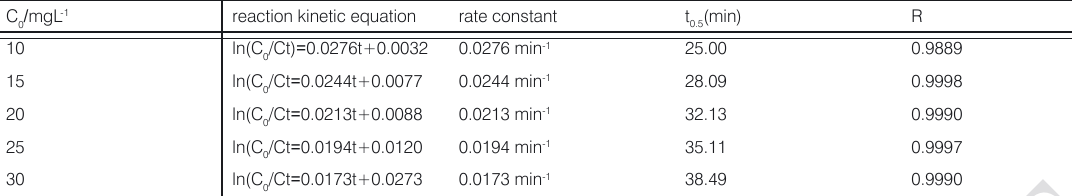
Table 1. Parameter and reaction kinetic equation for different initial concentration. C / mgL -1 reaction kinetic equation 0